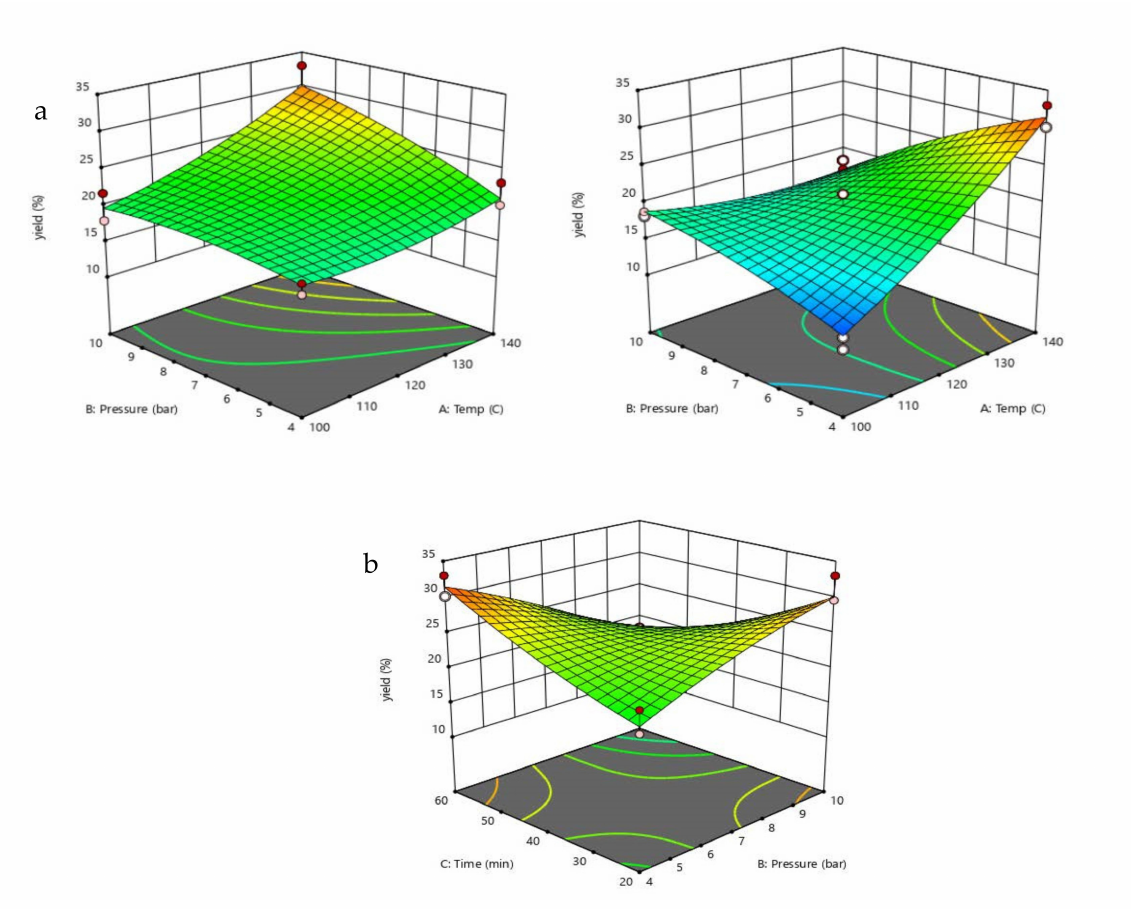
Figure 1. ( a ) Effect of the interaction of temperature and pressure and ( b ) effect of the interaction of pressure and time on extraction yield. A is temperature in term of coded unit, B is pressure in term of coded unit, and C is time in term of coded unit.